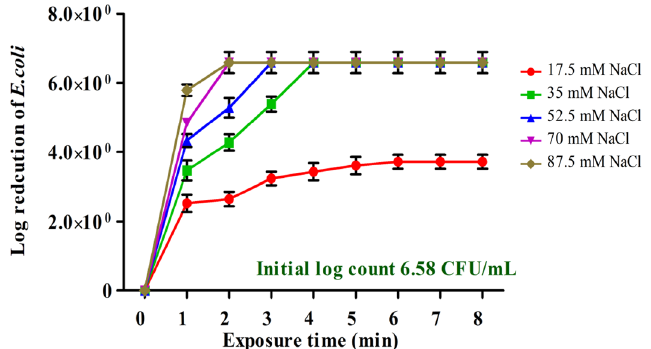
Figure 4. Effect of different concentrations of electrolyte concentration (17.5–87.5 mM NaCl) on E. coli during electrochemical inactivation treatment Experimental data are shown as mean ± standard deviation (n =